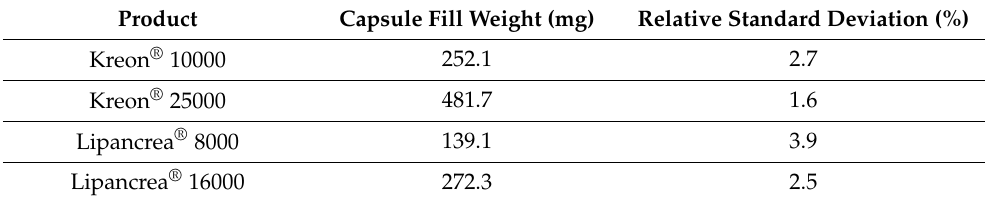
Table 1. Capsule fill weight ( n =